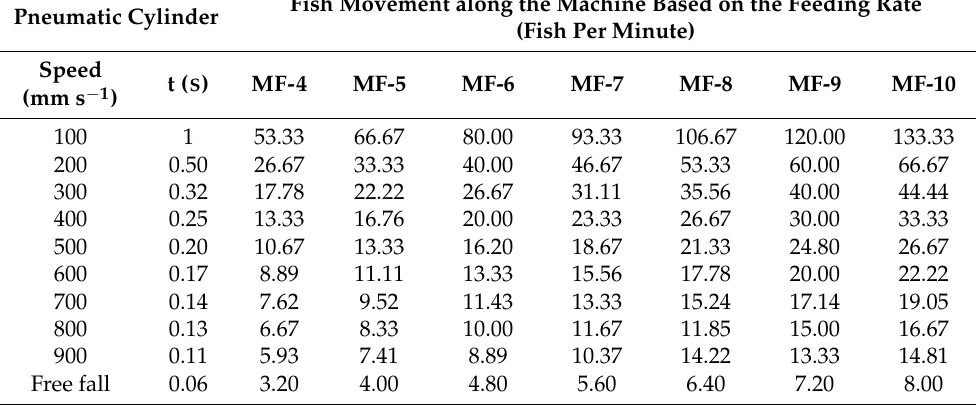
Table 2. Fish movement along the machine based on the feeding rate (fish per minute). Fish Movement along the Machine Based on the Feeding Rate Pneumatic Cylinder (Fish Per